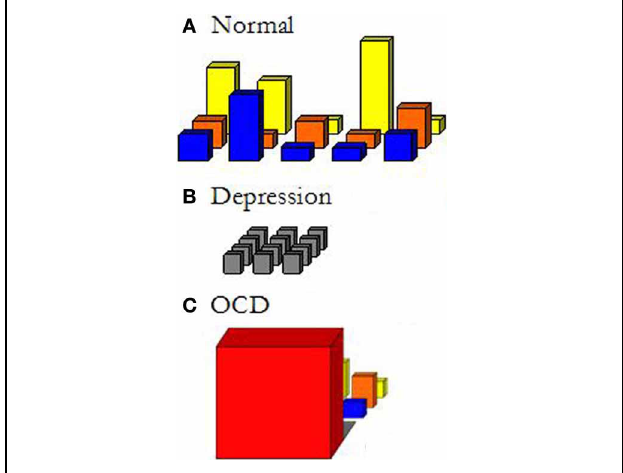
FIGURE 1 | Sketch of different fields of relevant